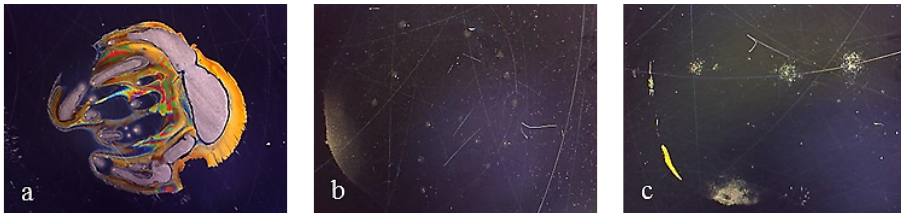
Figure 8. Working area after polarization on bare mirror finish: ( a ) X37CrMoV5-1; ( b ) X105CrCoMo18-2; ( c ) X40CrMo15.